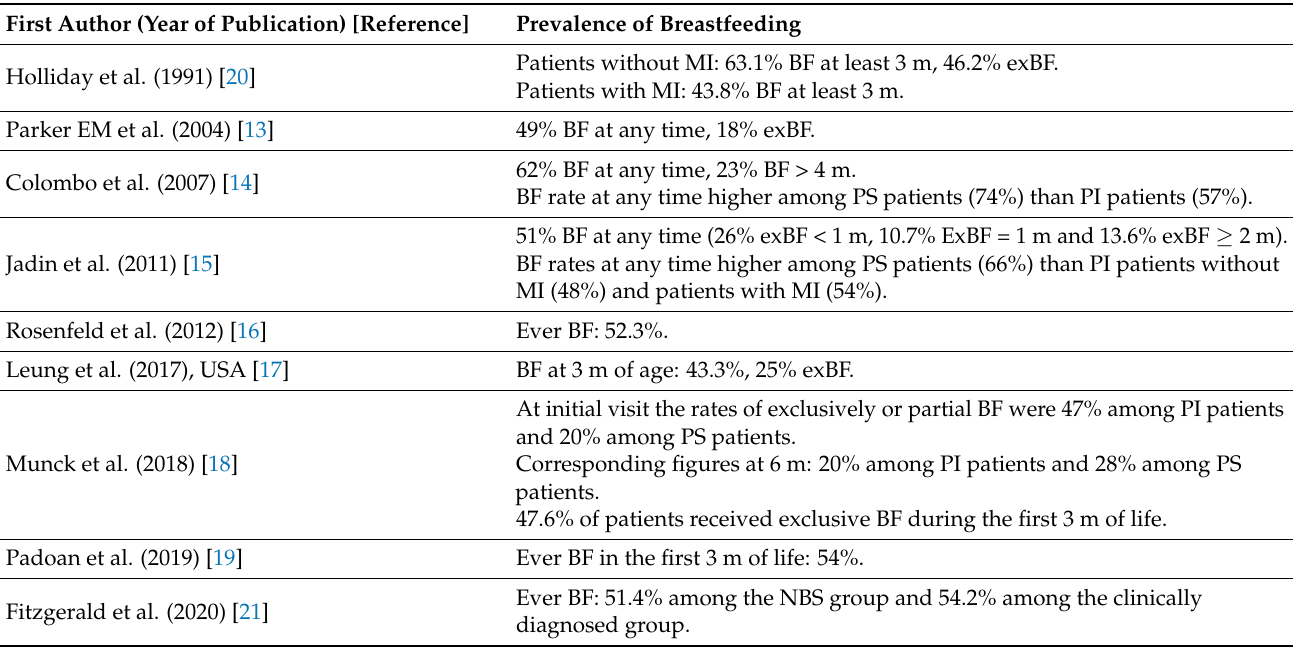
Table 3. Summary overview of the studies reporting on prevalence of breastfeeding in cystic